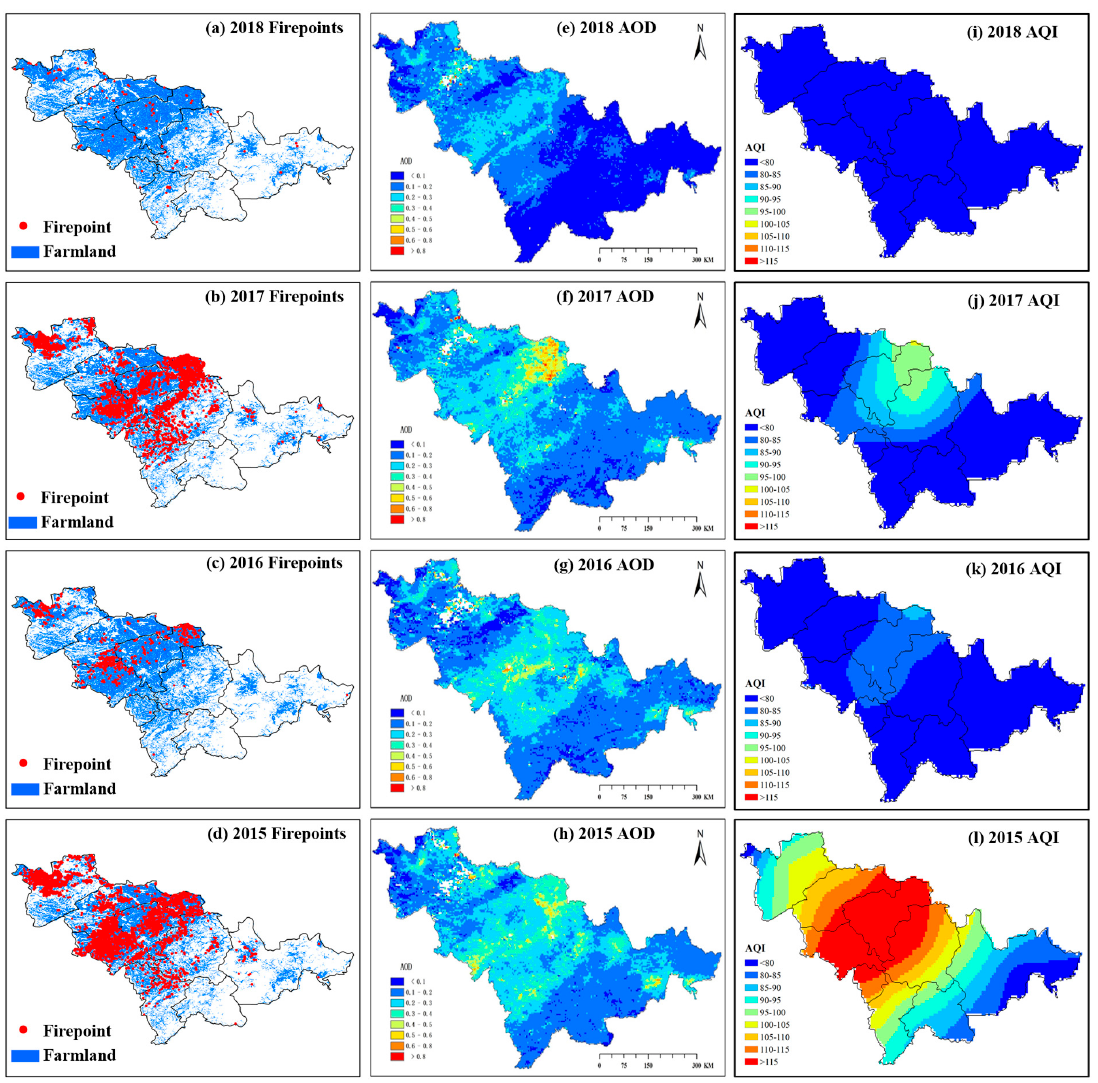
Figure 2. Spatial distribution of field fire points ( a – d ), aerosol optical thickness (AOD) ( e – h ) and air quality index (AQI) ( i – l ) during October and November from 2015 to 2018. Table 1. Air quality-related indexes for the major polluted cities during October and November of the period from 2015 to 2018.